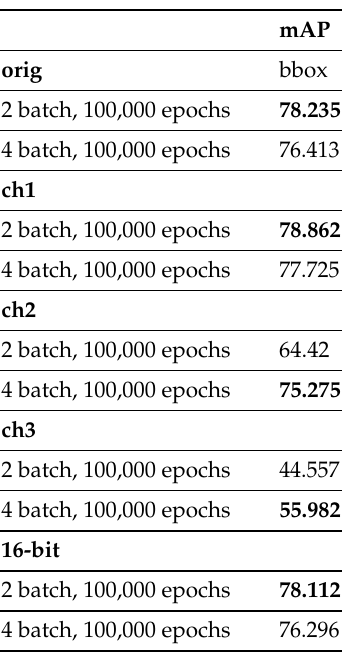
Table 5. Training results for TensorMask from scratch learning and 500